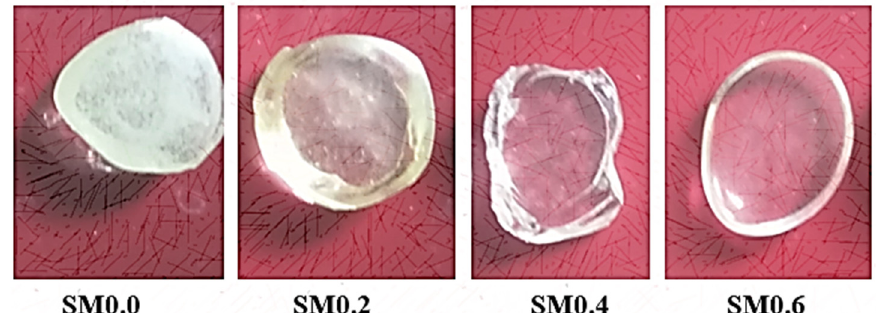
Figure 1. Fabricated (Tl 2 O 3 ) 30 -(Li 2 O) 10 -(B 2 O 3 ) (60 − y ) -(Sm 2 O 3 ) y glass system.